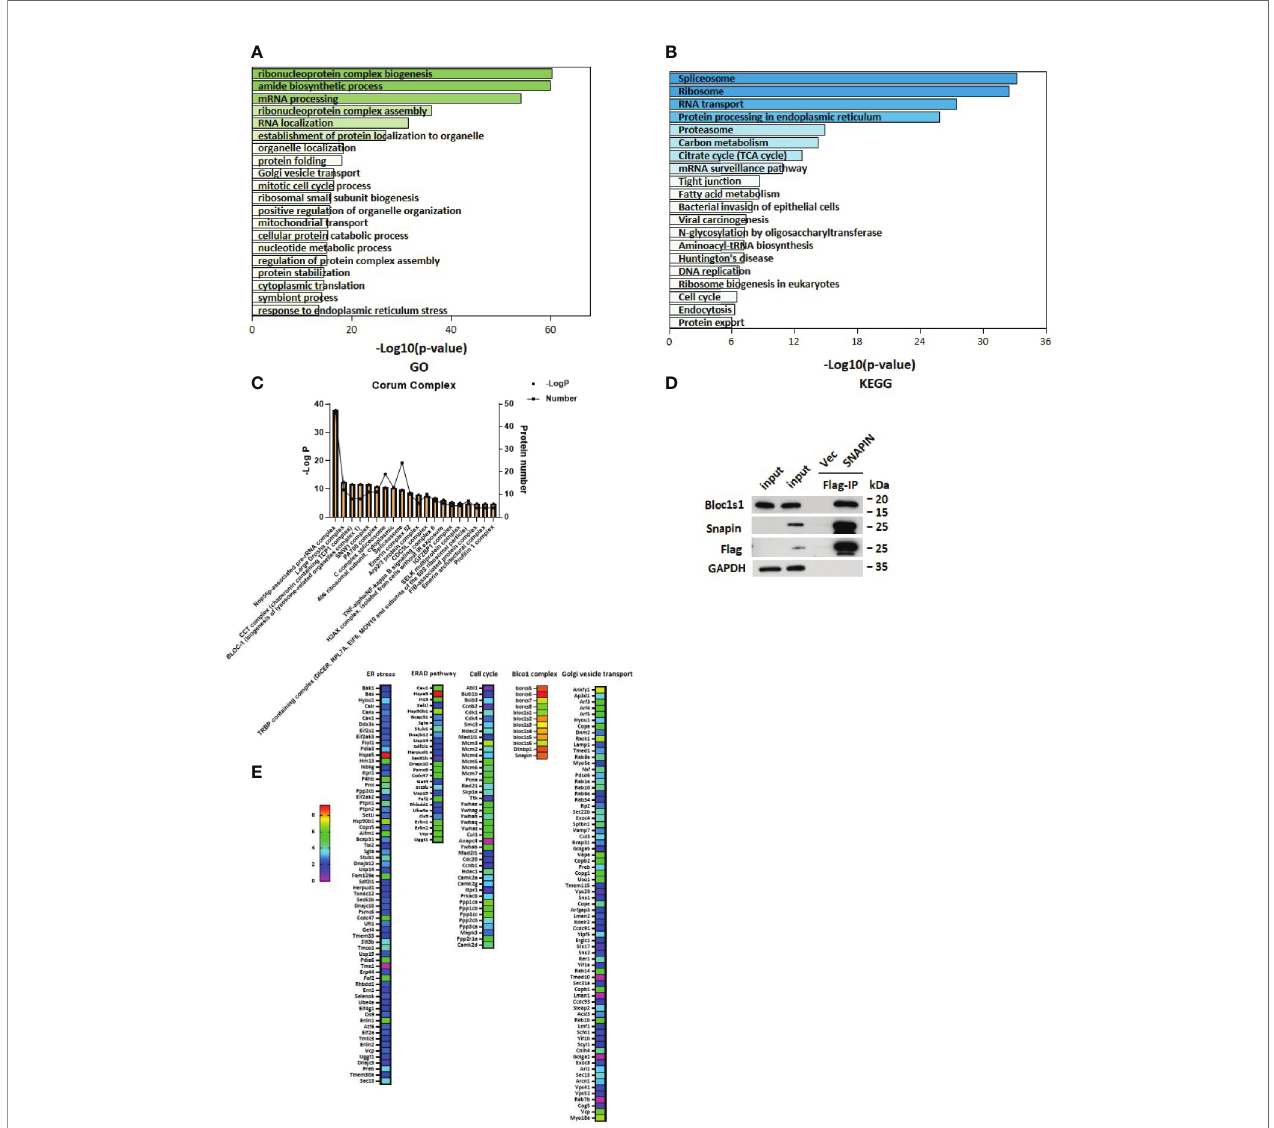
FIGURE 3 | Outputs of proteomic analysis for SNAPIN -altered proteins. Identity of the SNAPIN -binding proteins. Experimental work fl ow of the identi fi cation of the SNAPIN -interacting proteins. Min6 cells were transduced with SNAPIN with speci fi c sequences containing the 3xFlag tag. The resulting cell lysate was reacted with fl ag beads. The bound fraction was eluted and submitted for shotgun LC – MS/MS. (A, B) Pathways were enriched for common genes by employing the Database for Annotation, Visualization and Integrated Discovery (DAVID) ver. 6.8, KEGG pathway and GO pathway that represent functional classes of SNAPIN interacting proteins. (C) Proteins signi fi cantly interacting with SNAPIN were classi fi ed into different protein complexes. (D) IP was performed to measure the ef fi ciency of Flag pulldown. BLOCS1 was the positive control. (E) The SNAPIN - binding proteins were identi fi ed by Flag Immunoprecipitation pulldown. The heat map shows the score sequest HT, where the intensities in blue indicate the relative abundance of the protein in the